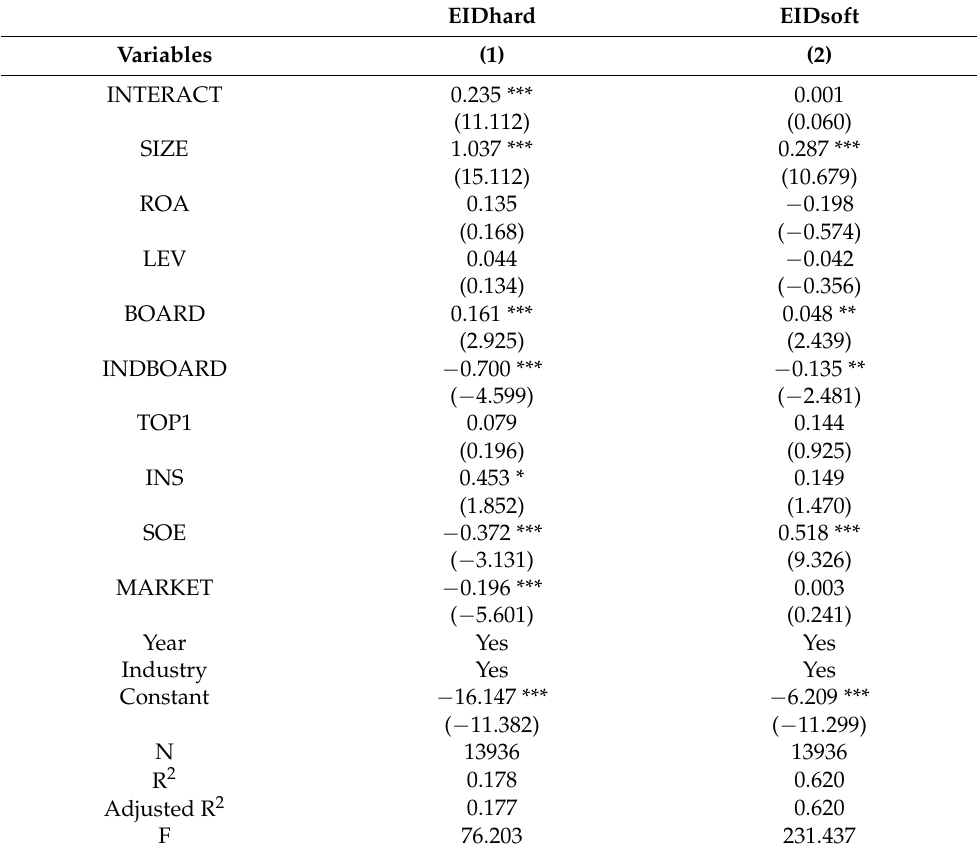
Table 9. Differential effects on EID hard information and EID soft